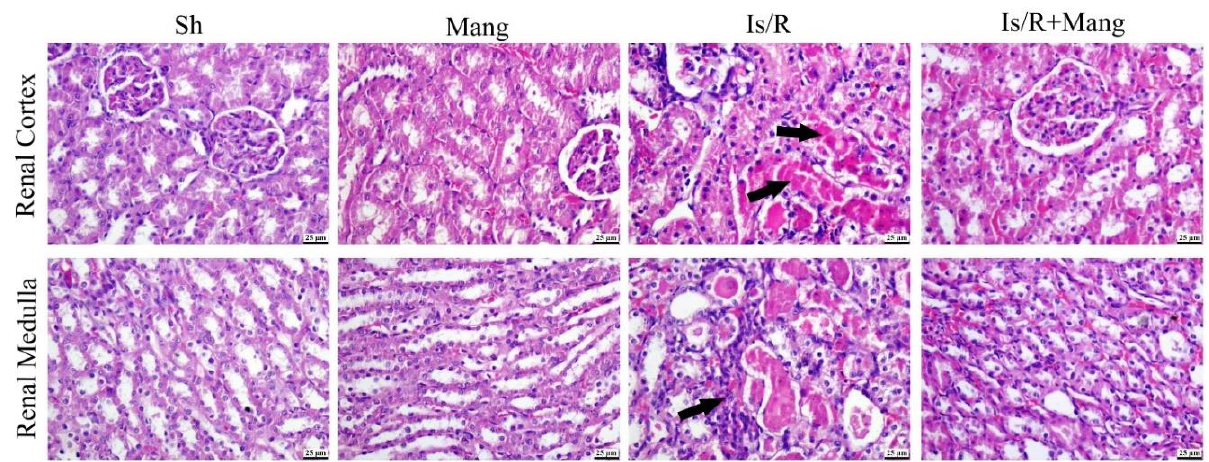
Figure 8. Mang ’s (20 mg/kg, i.p) impact on renal histopathological alterations of renal cortex and renal medulla after bilateral renal Is/R (45 min/24 h) in Wistar rats.